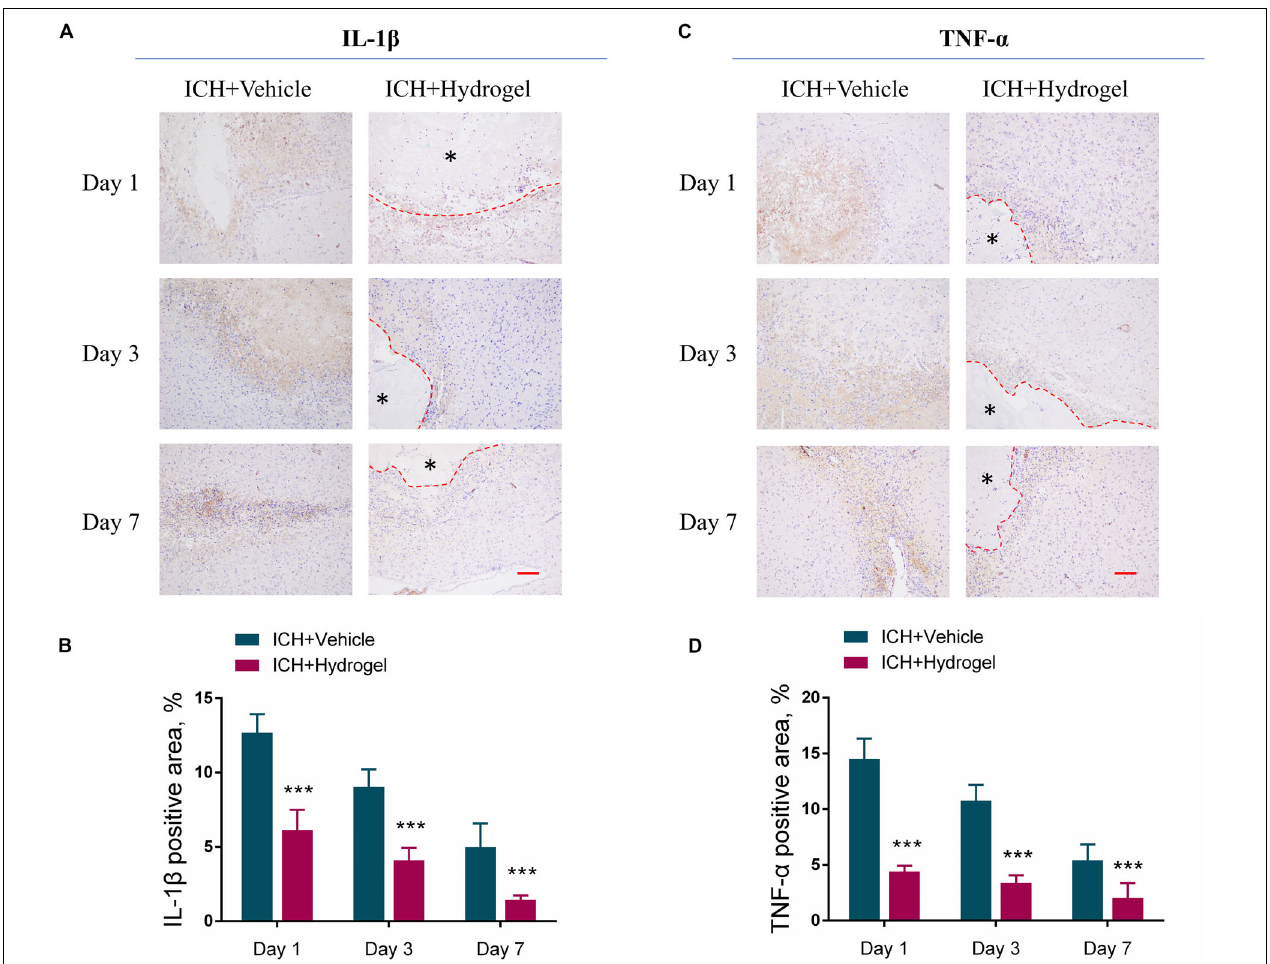
FIGURE 7 | Effects of gelatin hydrogel on pro-inflammatory cytokine. (A) Immunohistochemical staining of IL-1 β around the lesion. (B) The area percentage of IL-1 β . (C) Immunohistochemical staining of TNF- α around the lesion. (D) The area percentage of TNF- α . Scale bar = 50 µ m. *Represents the hydrogel. Data are mean ± SD, n = 4 mice per group, *** P <